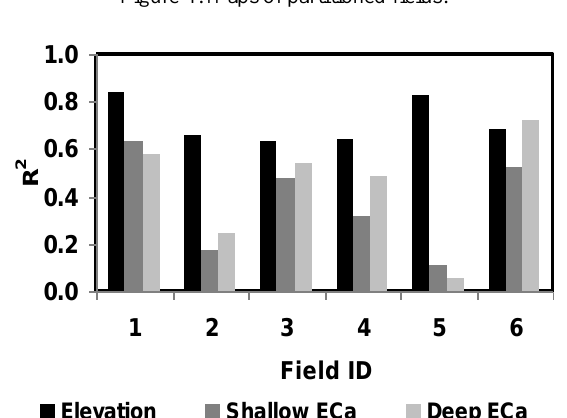
Figure 4. Maps of partitioned fields.